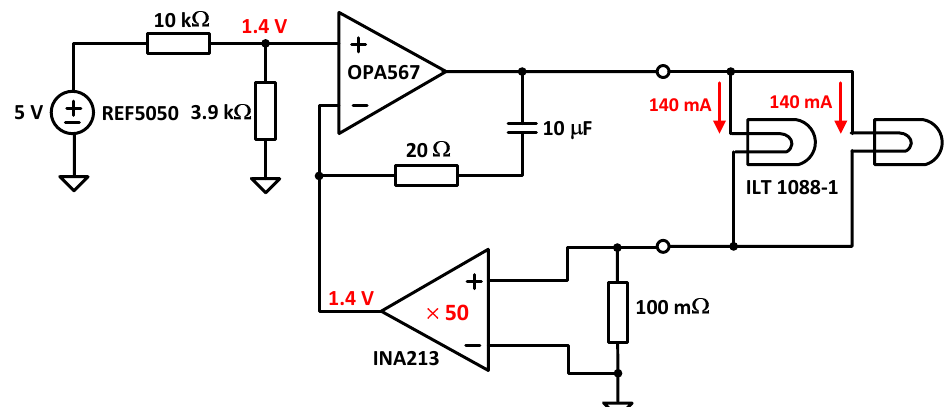
Figure 7. DLP NIRscan Nano lamp driver. Figure 8. DLP NIRscan Nano lamp driver.